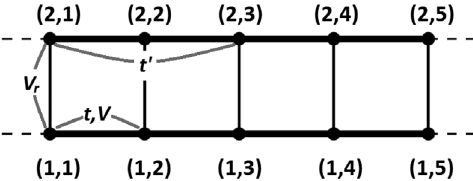
FIG. 5. Two-rung lattice made of two identical chains with nearest neighbor hopping ( t ), interaction ( V ), and next-nearest neighbor hopping( t 0 ).Thetwo chains interact alongtherungs ( V